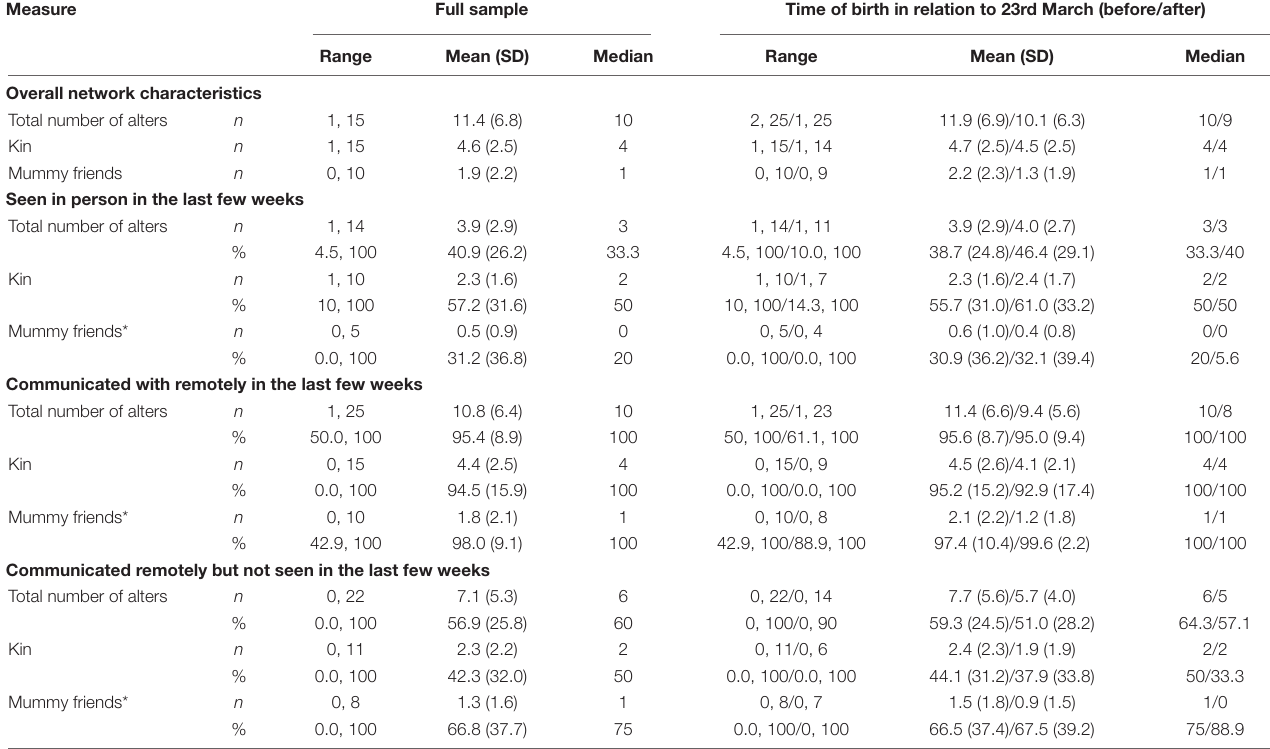
TABLE 1 | Table shows a summary overall personal network characteristics of the sample, along with a summary of patterns of communication with network alters ( N = 162). Measure